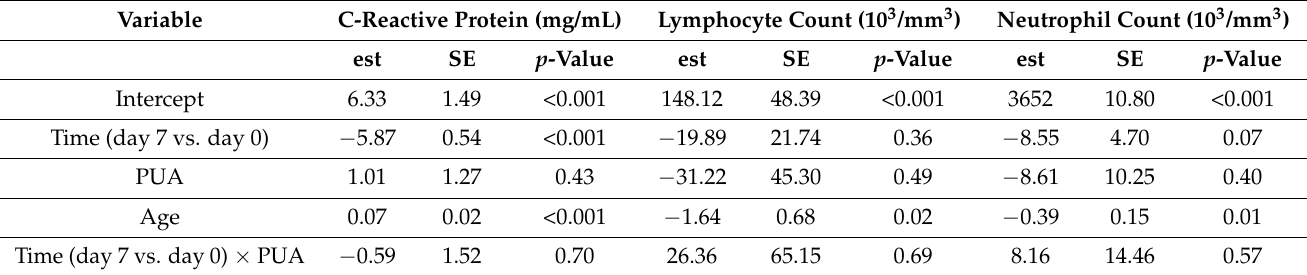
Table 5. Variation in laboratory findings at 7 days from baseline in linear mixed